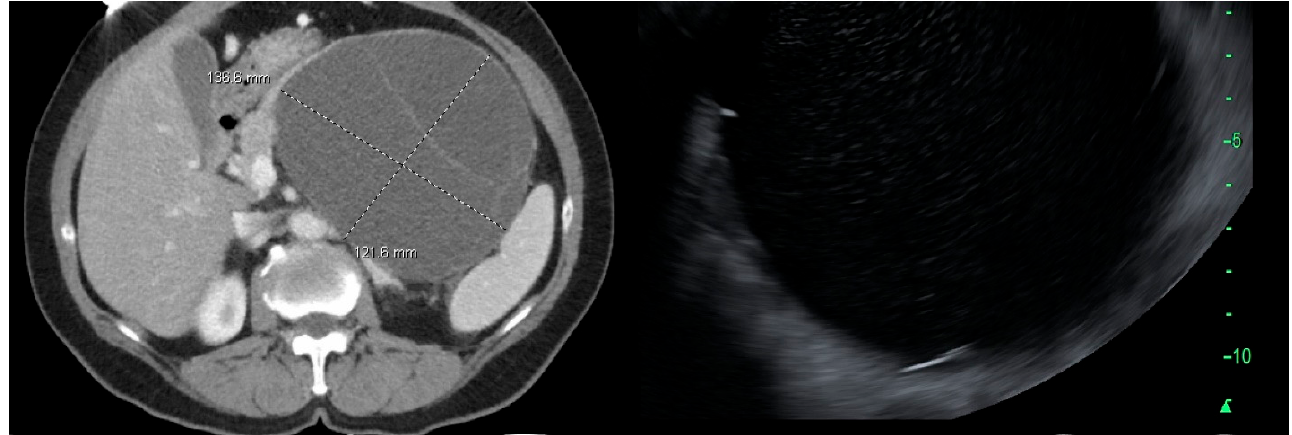
Figure 3. CT scan and endoscopic ultrasound images of mucinous cystic neoplasm in the body and tail of pancreas.